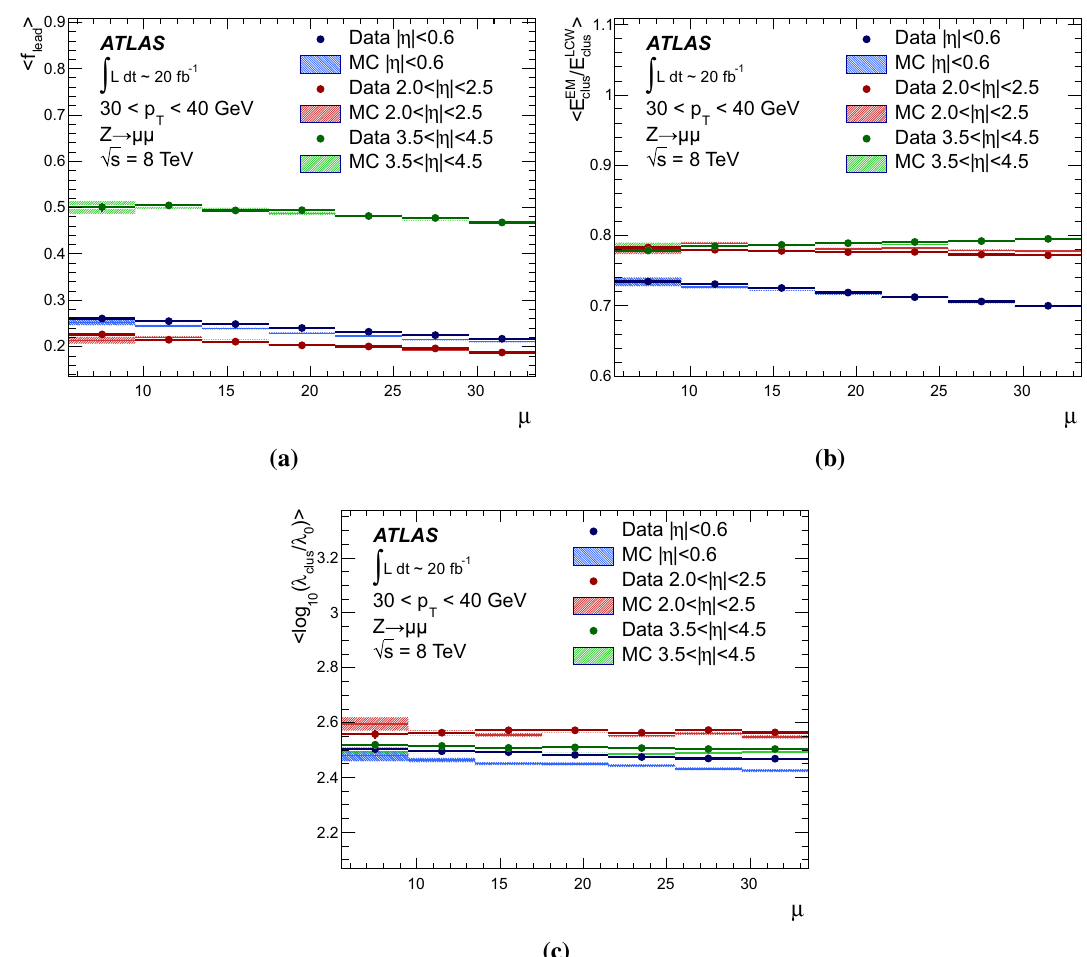
Fig. 40 The pile-up dependence of a f lead defined in Eq. (45), b / E LCW E EM , and c the depth location λ clus of the leading topo-cluster clus clus in fully calibrated anti- k t jets reconstructed with R = 0 . 4 and with < 40GeV in Z → μμ events in 2012 data 30GeV < p LCW + JES T , jet